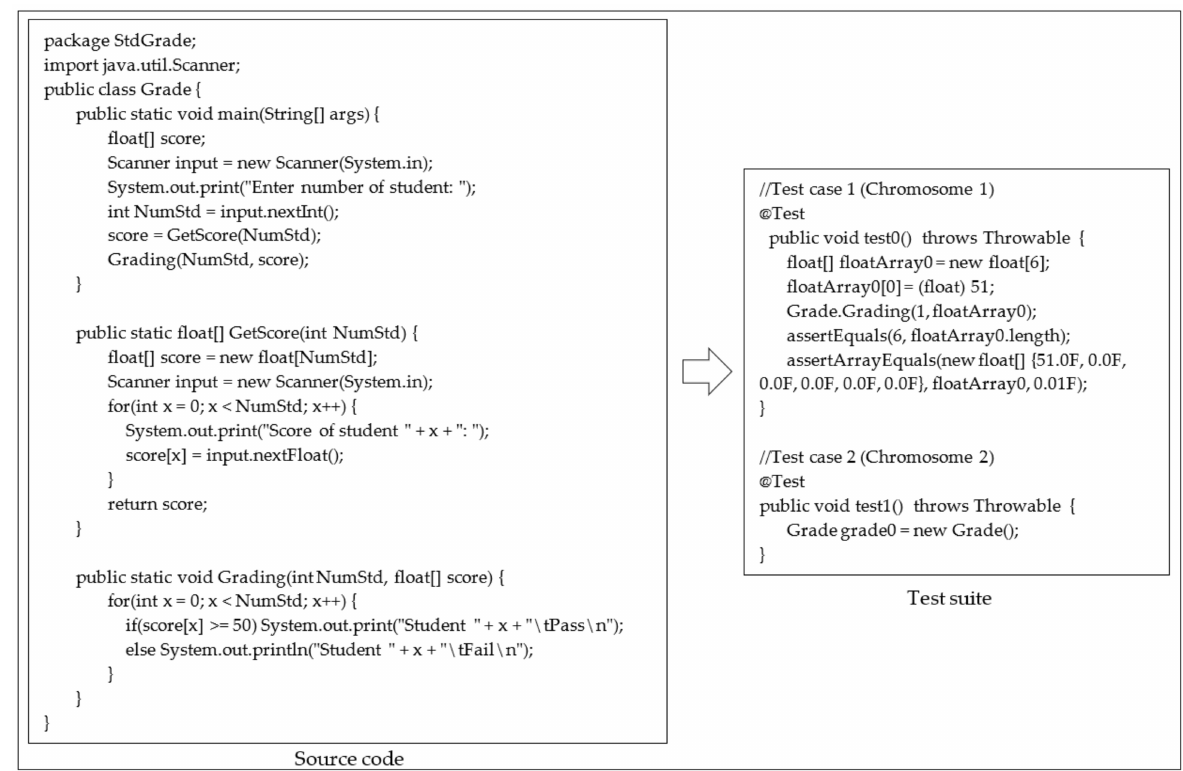
Figure 1. Chromosome